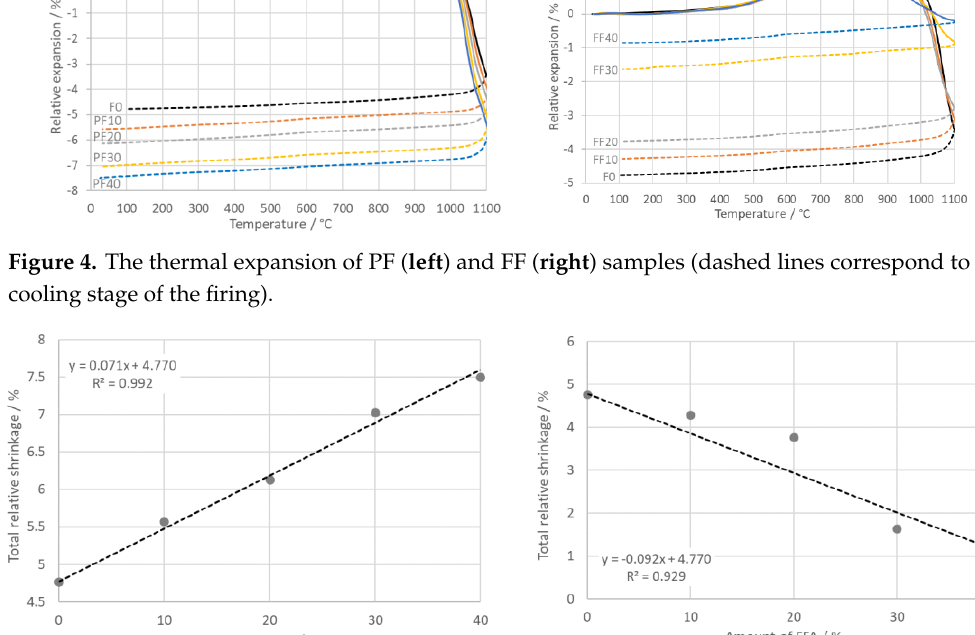
Figure 6. The bulk density of PF ( left ) and FF ( right ) samples (dashed lines correspond to the cooling stage of the firing). The final values of the bulk density linearly depended on the content of PFA and FFA, see Figure 7. For PFA, it was as follows: ρ = 1.870 − 0.003 ·c (PFA); R 2 = 0.802; c (PFA) is a part of PFA in mass%. Similarly, for FFA, it was: ρ = 1.870 − 0.014 ·c (FFA); R 2 = 0.973; c (FFA) is a part of FFA in mass%. A lower bulk density has advantages: lower bulk density is generally reflected in better thermal insulation properties of the building ceramics.